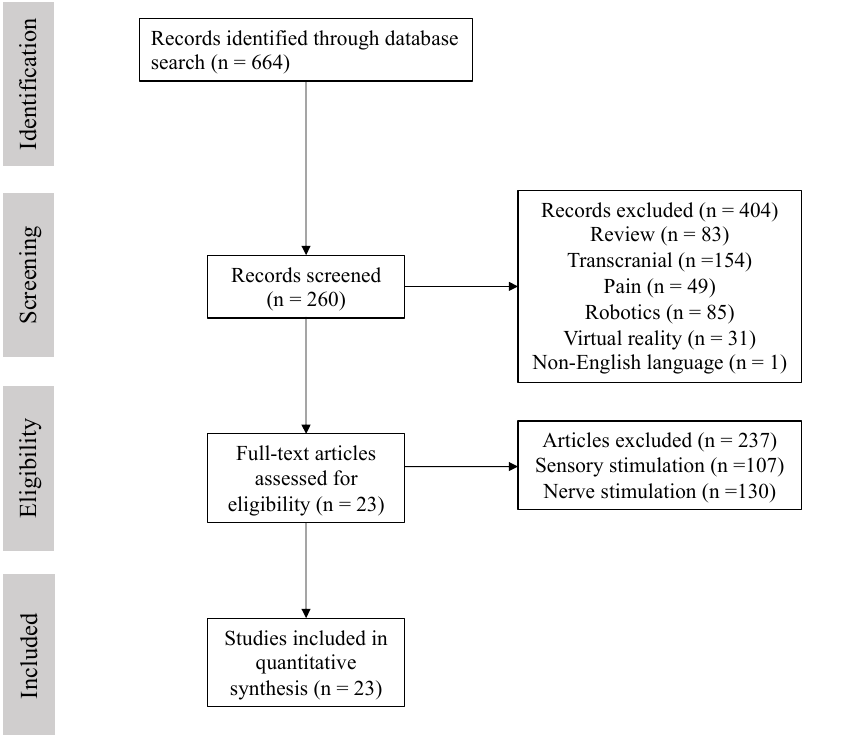
Figure 1. Flow diagram for included studies.